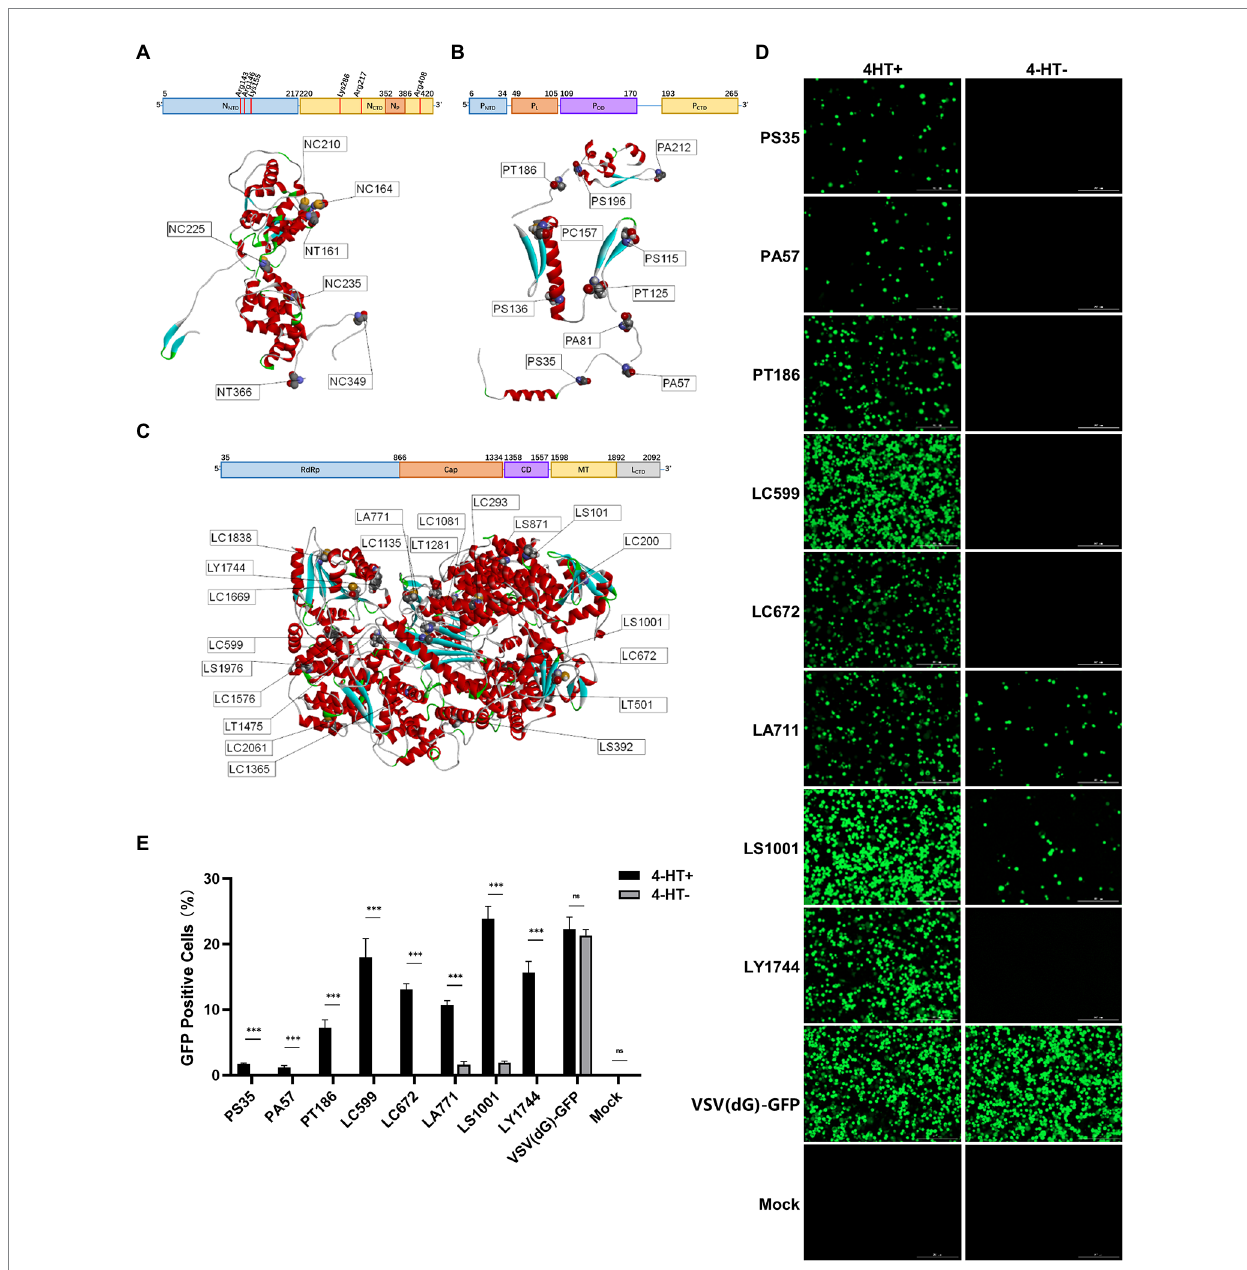
FIGURE 2 Screening regulation of intein insertion sites in viral proteins of VSV. (A–C) The structures and function domains of VSV nucleoprotein (A) , phosphoprotein (B) , the large RNA polymerase (C) , and the intein insertion sites selected on the structures. N protein domains (Green and Zhang, 2006): N-terminal domain (N NTD ); C-terminal domain (N CTD ); and RNA-binding sites are shown in red vertical lines. P protein domains (Jenni and Bloyet, 2020): N-terminal domain (P NTD ); L protein-binding domain (P L ); oligomerization (P OD ); and C-terminal domain (P CTD ). L protein domains (Jenni and Bloyet, 2020): RNA-dependent RNA polymerase domain (RdRp); capping domain (Cap); connector domain (CD); methyltransferase (MT); and C-terminal domain (CTD). (D) The GFP expression level of the recombinant 4-HT-regulated VSV and the percentages of GFP-positive cells were analyzed by FACS (E) . Significance of results were evaluated by Mann Whitney test between two groups. p value less than 0.05 was considered significant. * p < 0.05; ** p < 0.01; *** p < 0.001; n.s., not